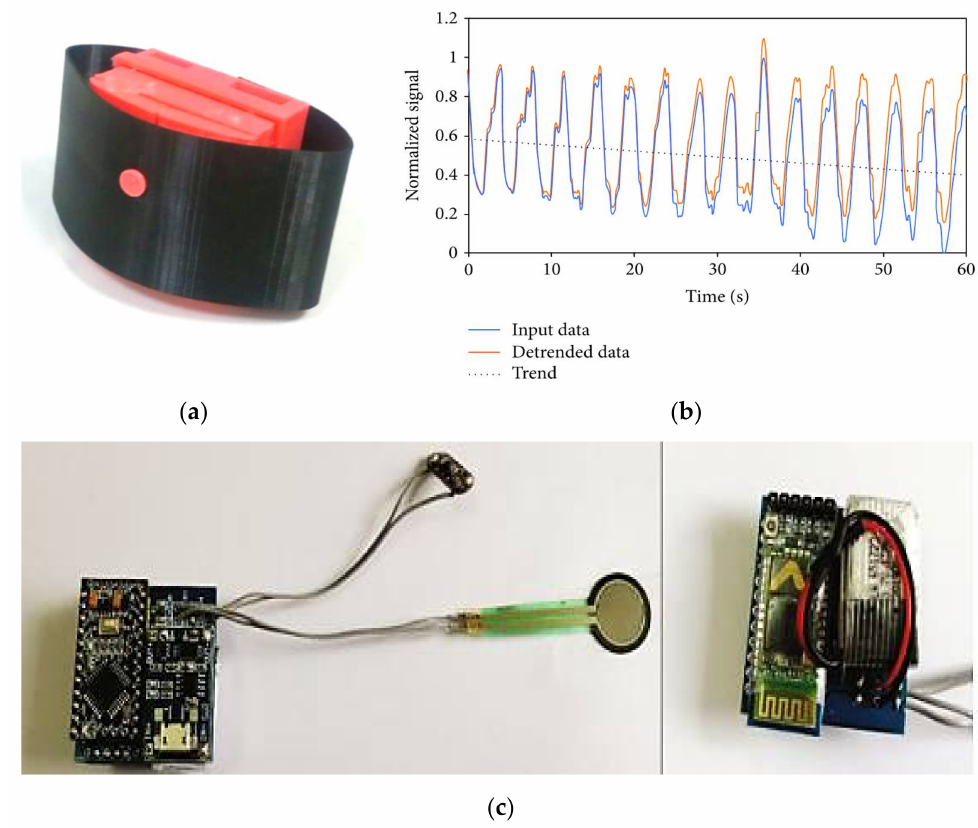
Figure 1. Prototype of the wearable device for RR monitoring proposed in [50] ( a ); waveforms acquired by the device: original data (red curve), shifted data (blue curve), and the zero axis (dotted line) ( b ); prototype of the sensing system mounted ( c